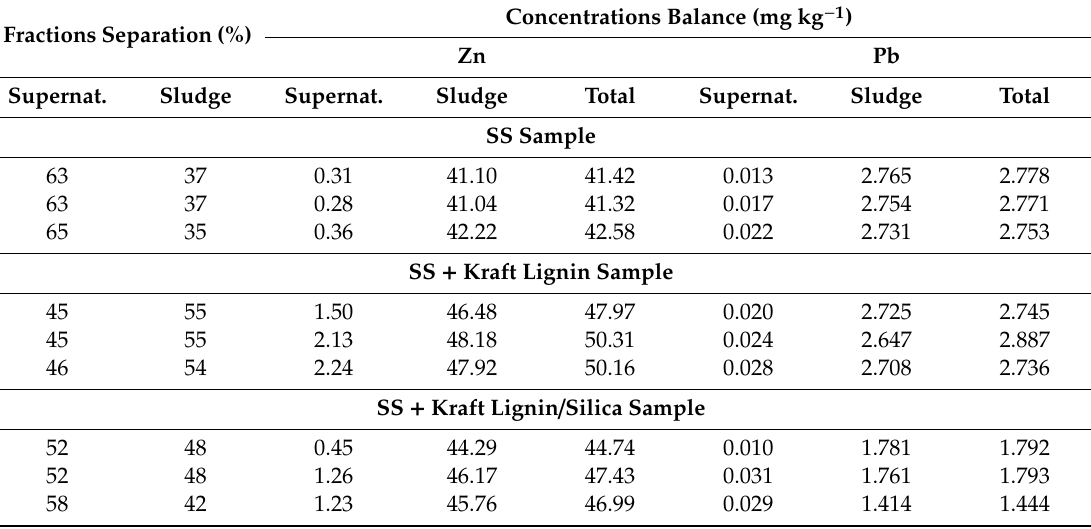
Table 5. Zinc and lead concentration in digested SS, SS + kraft lignin and SS + kraft lignin / silica samples. Fractions Separation (%)